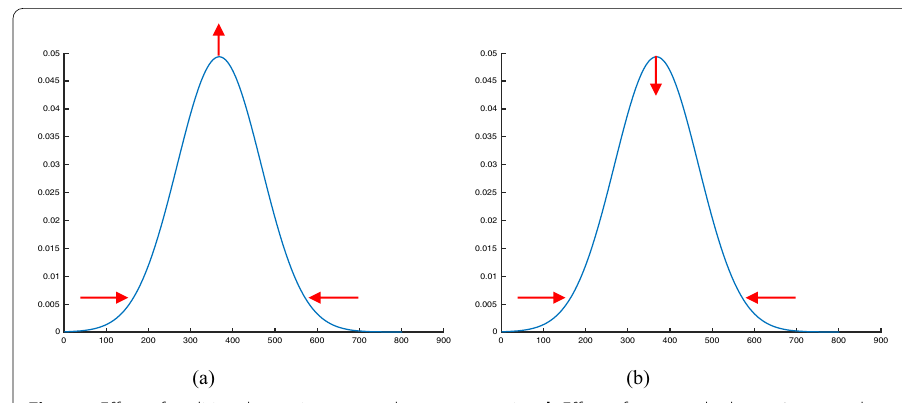
Fig. 1 a Effect of traditional gaussian approach on compression. b Effect of proposed scheme 2 approach on compression in x and y axes